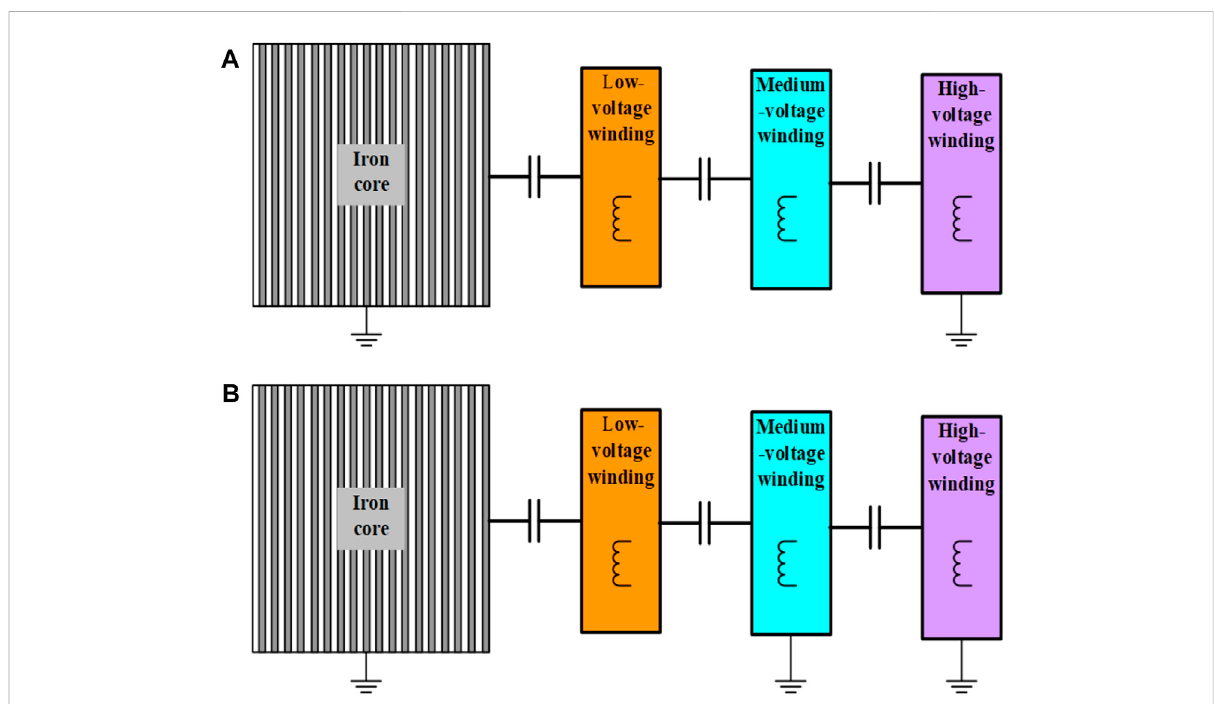
FIGURE 6 Single point grounding diagram of YN/YAI and YNynd11 cores: (A) YN/YAI structure; (B) YNynd11